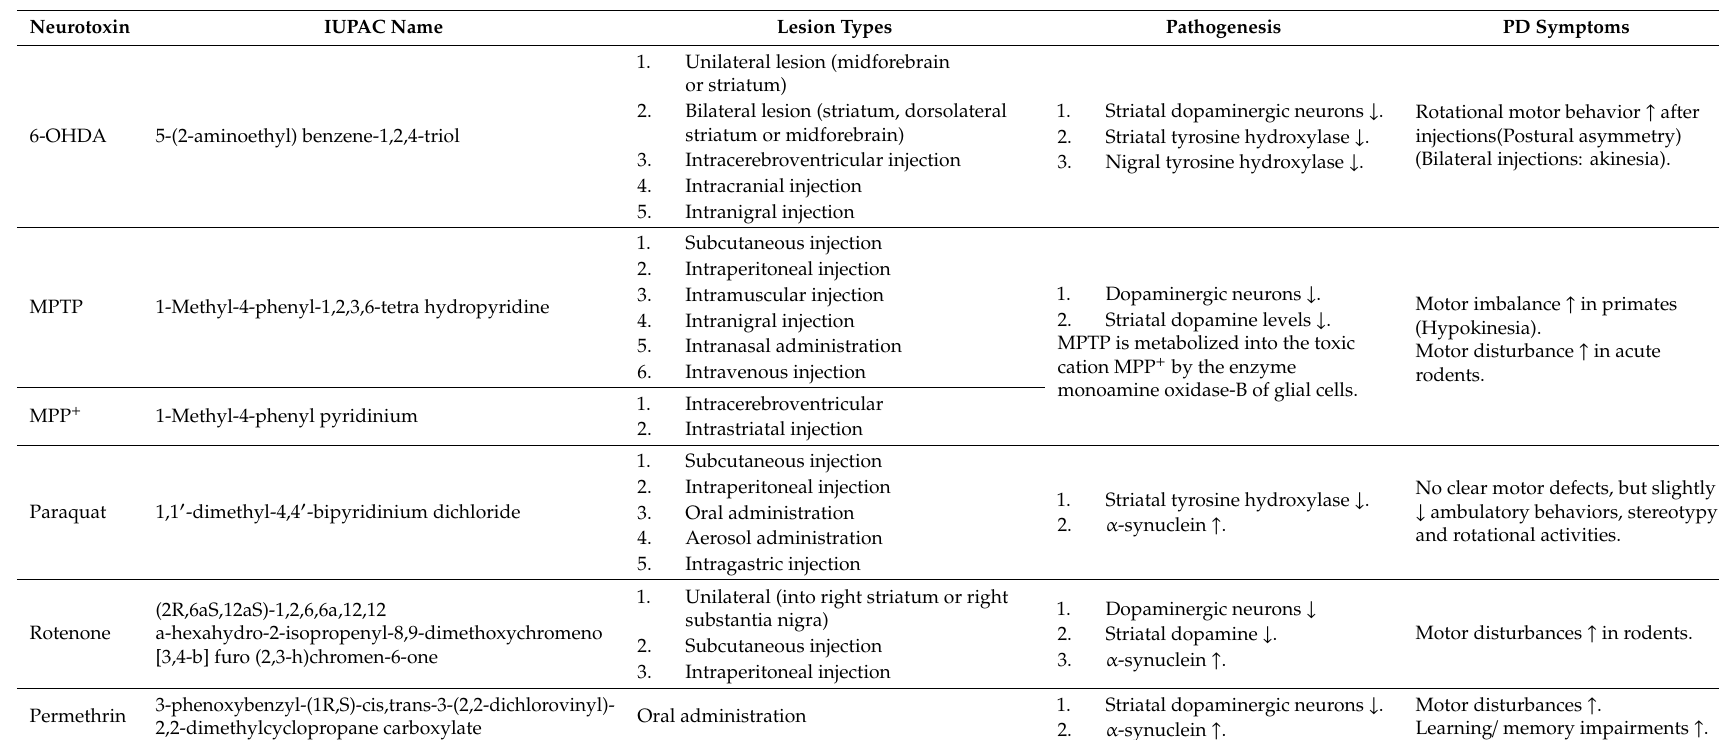
Table 1. Neurotoxins, lesion types, pathogenesis, and symptoms of Parkinson’s disease